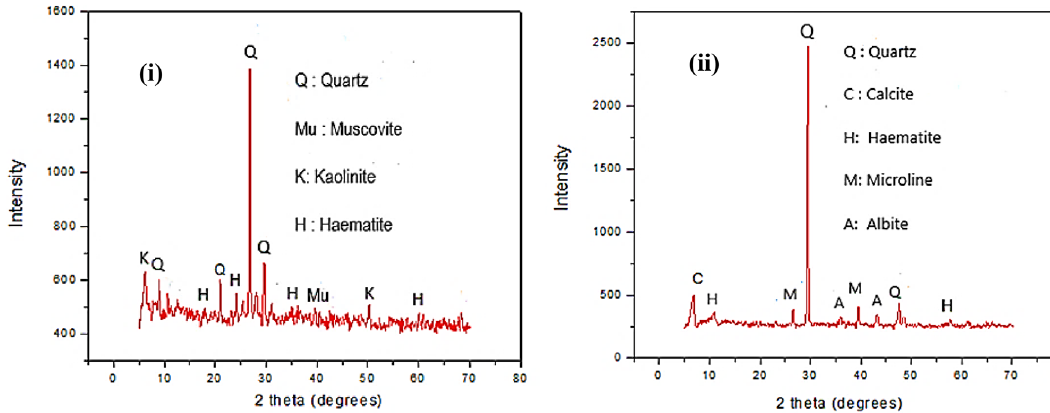
Fig. 2 The X-ray diffraction patterns of (i) clay sample and (ii) granite powder Fig. 3 SEM micrographs of raw materials (i) granite powder and (ii) natural